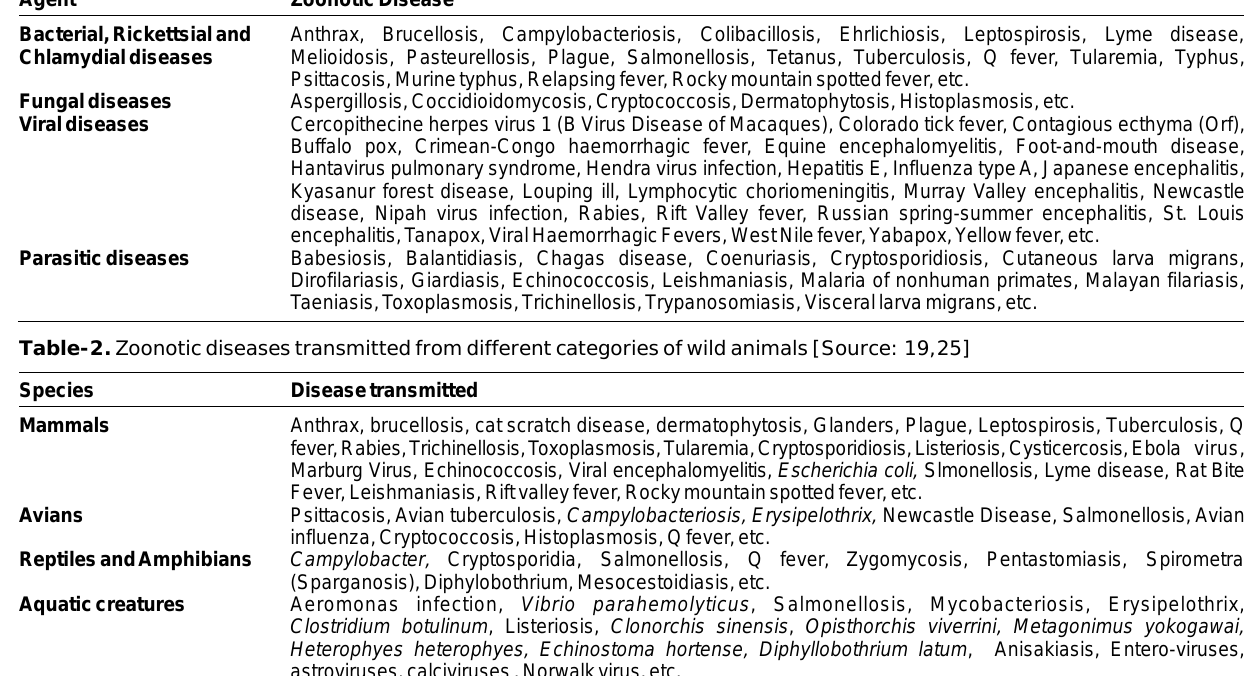
Table - 1. Major zoonotic diseases with relevance to wild animals [Source: 12,19,25] Agent Bacterial, Rickettsial and